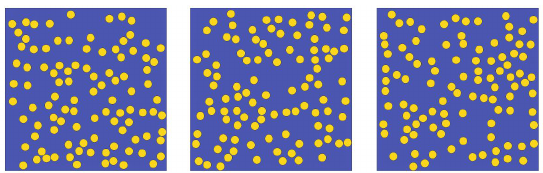
Figure 4: The generated random models with 50, 100, 200 and 400 fibers for v f = 65%